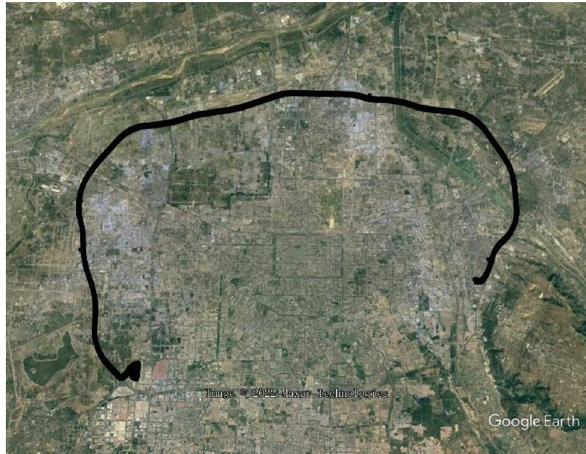
Figure 5. Test track of vehicle in Xi’an ring expressway.